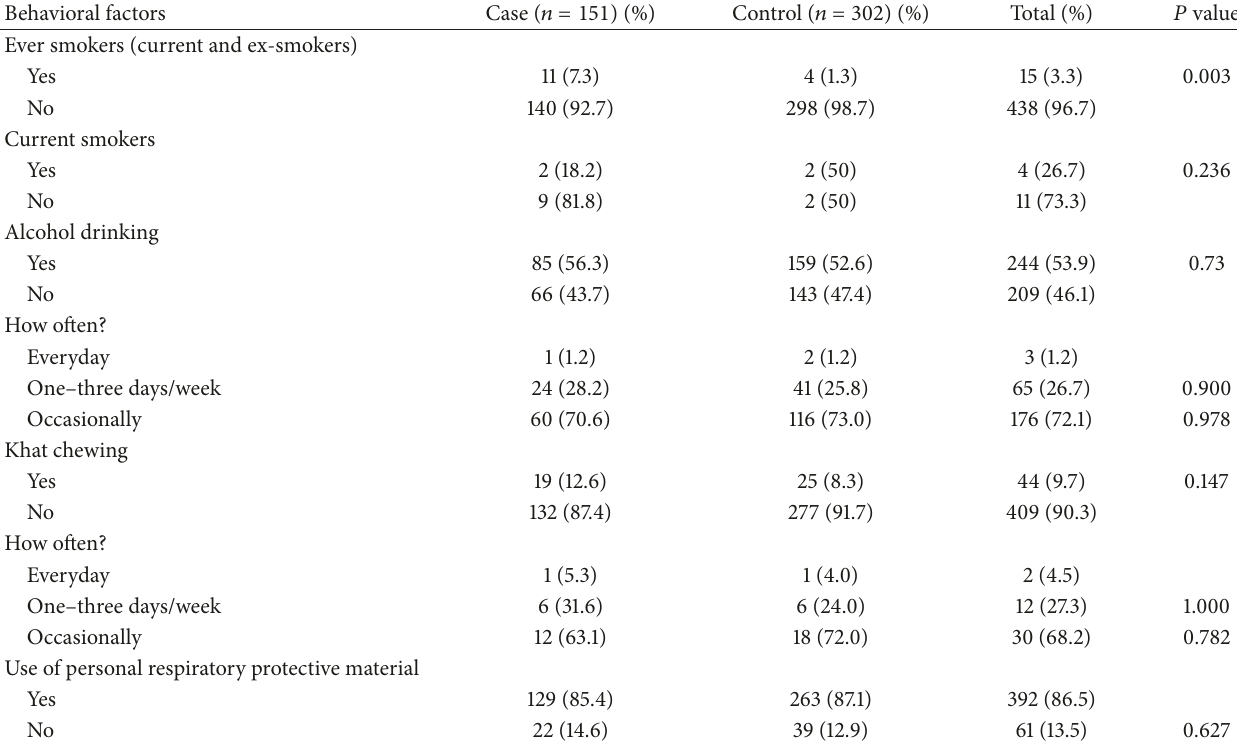
Table 3: Distribution of behavioral factors of participants in pharmaceutical factories in Addis Ababa, Ethiopia, May 2017. Behavioral